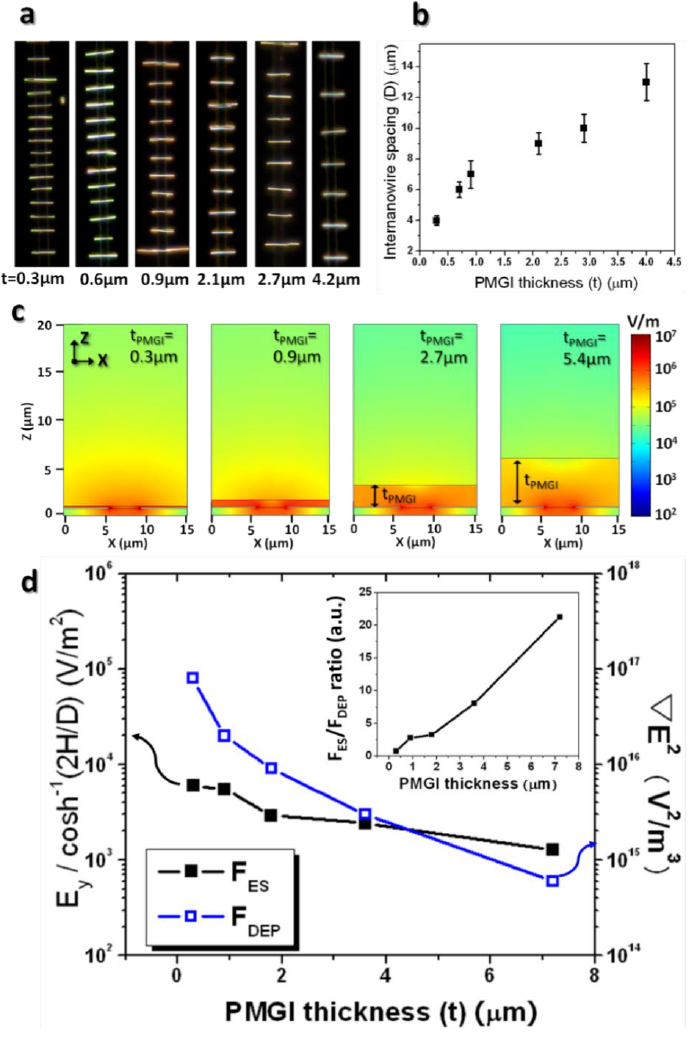
Figure 5. Inter-nanowire spacing as a function of the dielectric layer thickness. ( a ) Series of dark-field optical microscopic images for the different thicknesses of PMGI layers (t PMGI = 0.3, 0.6, 0.9, 2.1, 2.7, and 4.2 μm), and ( b ) its plot for the relationship between the inter-nanowire spacing and PMGI thicknesses. ( c ) Spatial electric field distribution at different thicknesses of PMGI layers (t PMGI = 0.3, 0.9, 2.7, and 5.4 μm) exhibiting the electric field’s spread toward the liquid medium. Smaller number of nanowires in the suspension will be polarized, dielectrophoretically attracted, and redistributed on thicker PMGI layers, leading to smaller inter-nanowire spacing. This is due to the electric field’s decaying relatively quickly on thick PMGI layers. ( d ) Plot of the electrostatic repulsive (E y /cosh − 1 (2H/D)) and dielectrophoretic ( ∇ E 2 ) forces as functions of PMGI thickness. The inset shows that ratios of electrostatic to dielectrophoretic forces increase nearly linearly as the PMGI thickness